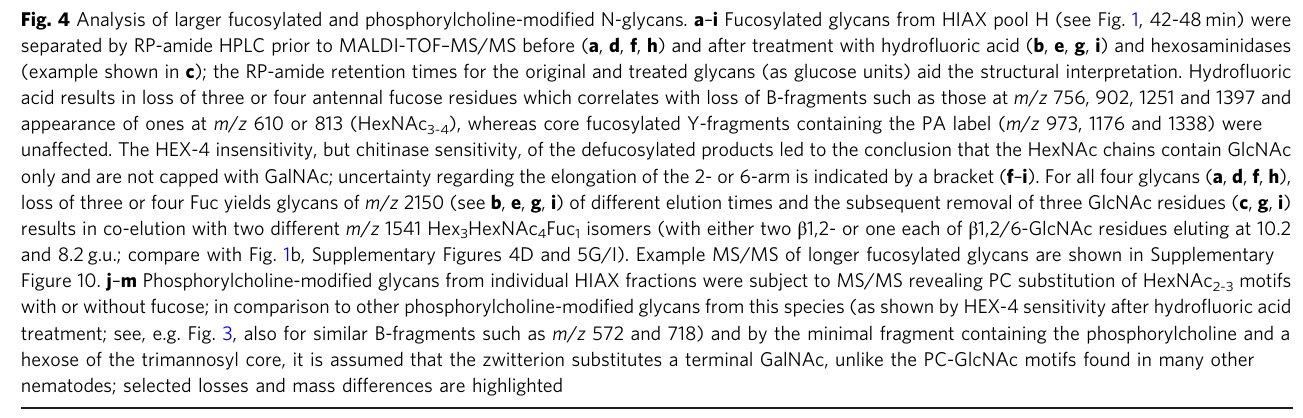
Fig. 4 Analysis of larger fucosylated and phosphorylcholine-modi fi ed N-glycans. a – i Fucosylated glycans from HIAX pool H (see Fig. 1, 42-48 min) were separated by RP-amide HPLC prior to MALDI-TOF – MS/MS before ( a , d , f , h ) and after treatment with hydro fl uoric acid ( b , e , g , i ) and hexosaminidases